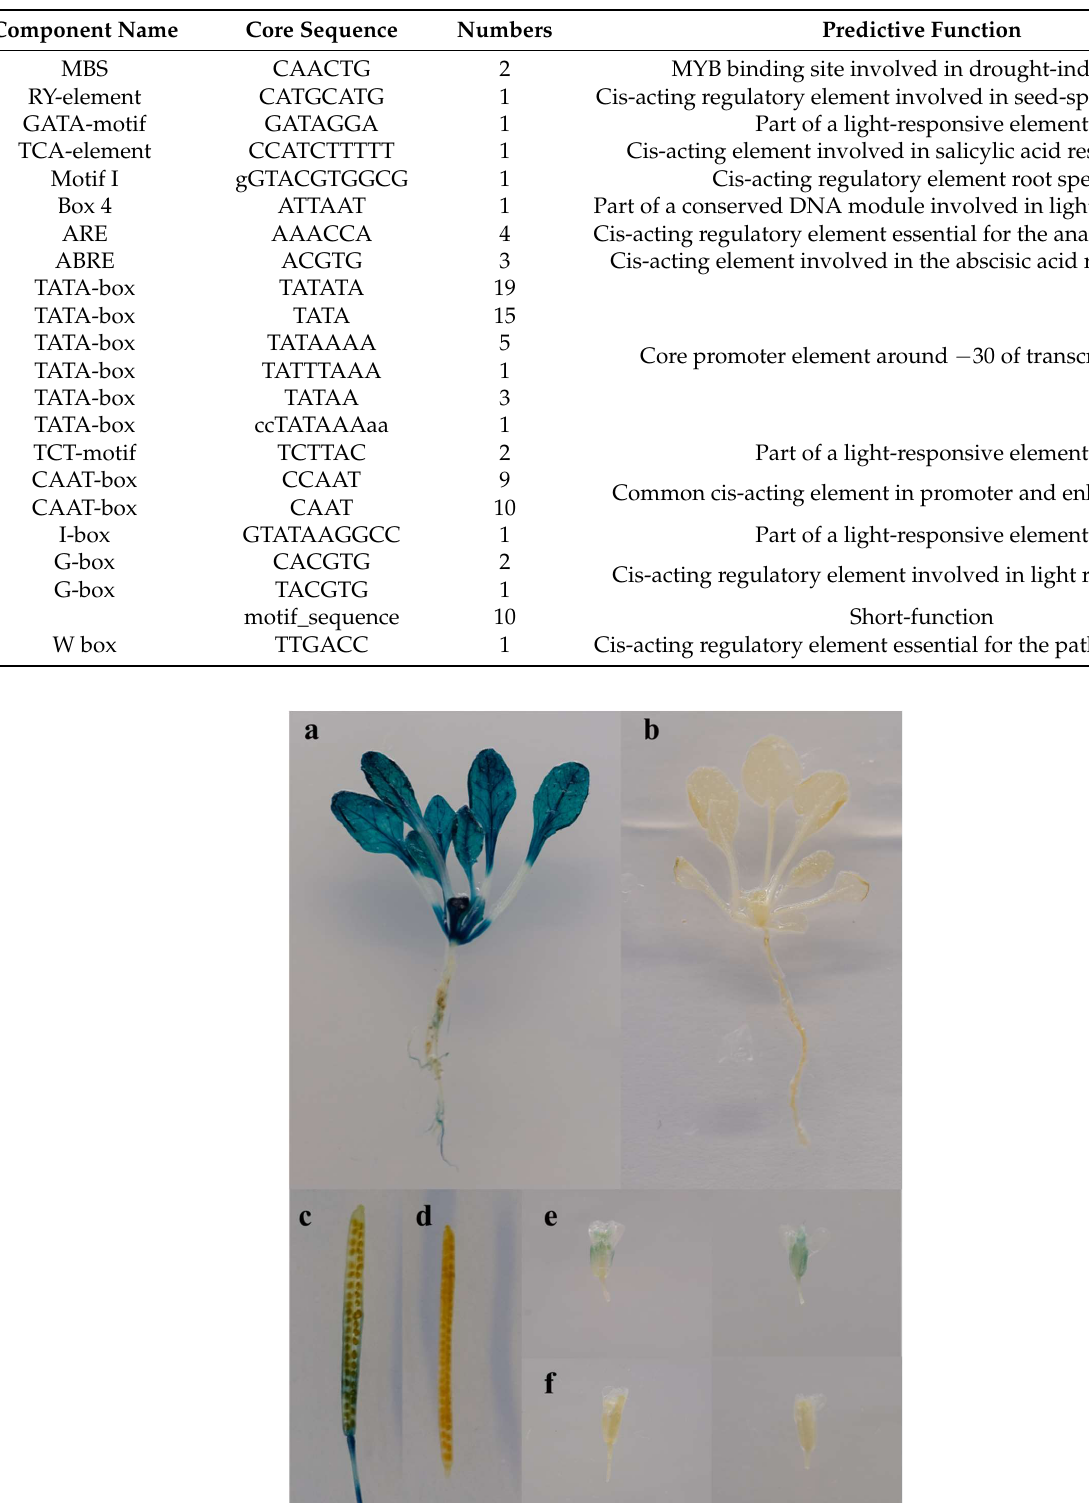
Table 2. Analysis of cis − acting elements in the Brgolden promoter.